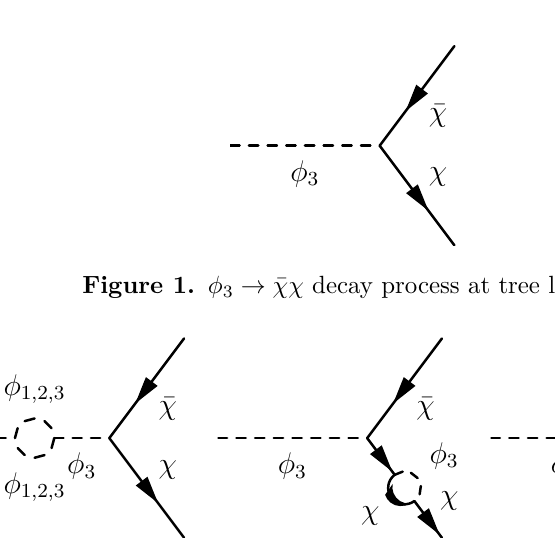
Figure 2. One-loop virtual corrections to the φ 3 → ¯ χχ decay